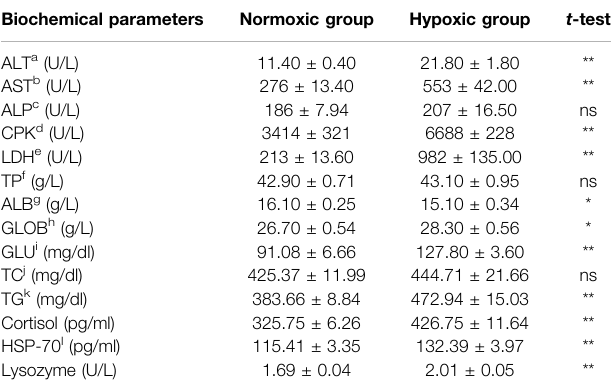
TABLE2| Effectofacutehypoxicstressontheplasmabiochemicalparametersof triploid rainbow trout ( n = 6). Biochemical parameters